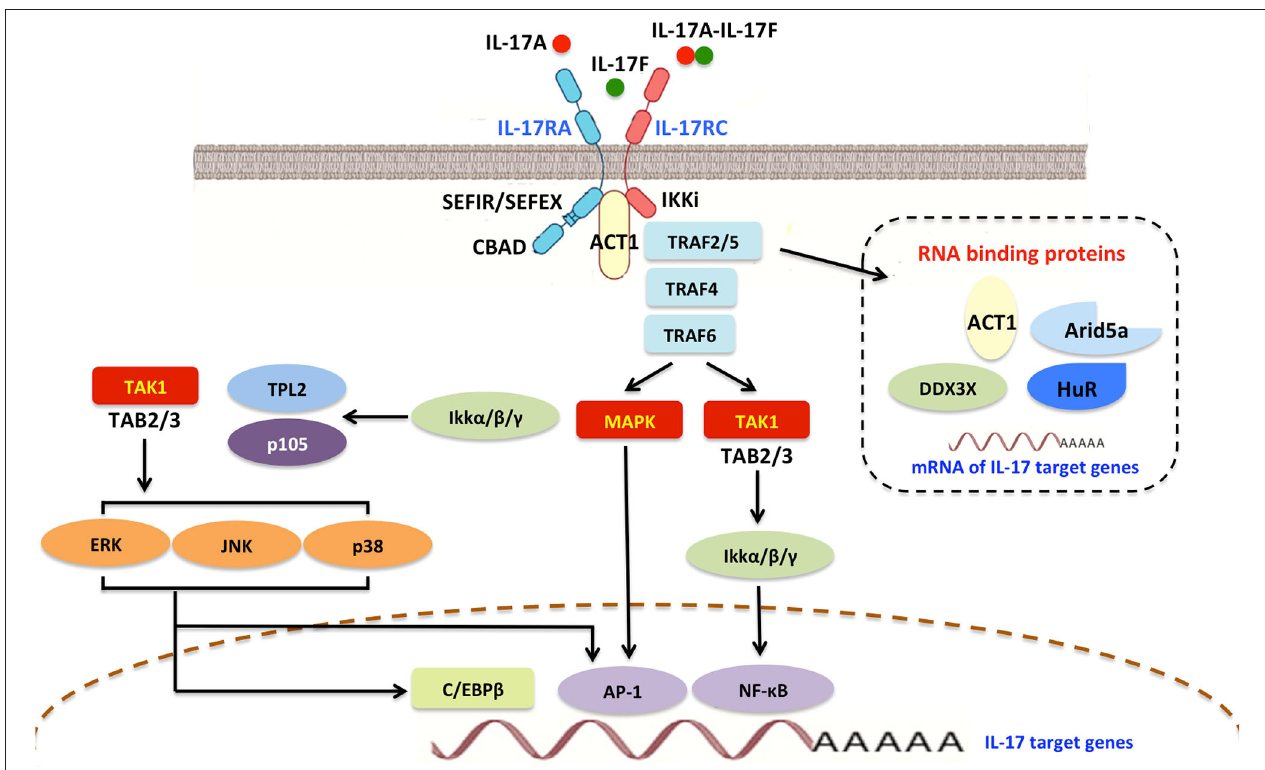
FIGURE 3 | Interleukin-17A signaling transduction pathway. In general, all IL-17R members contain a shared and conserved cytoplasmic motif named a SEFIR/SEFEX domain similar to the TIR region in IL-1 receptors and TLRs. Initially, IL-17R signaling triggers the recruitment of Act1, which includes a SEFIR domain and is required for IL-17R-Act1 combination. Subsequently, Act1 can ubiquitinate TRAF6 and E3 ubiquitin ligase. Upon ligand binding, TRAF2/5, TRAF4, and TRAF6 can be engaged by Act1 and stabilize mRNAs by activating RNA-binding proteins such as Arid5a, HuR, and DDX3X. IL-17A promotes the activities of AP1 and MAPK, as well as δ transcription factors and C/EBP β activation (CBAD). IL-17A also accelerates I κ B α degradation and IKK activation, thereby inducing NF- κ B signaling. NF- κ B in turn improves IL-17A-mediated proinflammatory and anti-microbial responses. IL-17A/NF- κ B signal transduction can trigger a feedback loop that controls overactivation of the NF- κ B cascade. TRAF, TNF-receptor associated factor; SEFIR, similar expression of fibroblast growth factor and IL-17Rs; SEFEX, SEFIR extension; TLRs, Toll-like receptors; C/EBP β , CCAAT/enhancer-binding protein β ; CBAD, C/EBP β activation domain; AP1, activator protein 1; MAPK, mitogen-activated protein